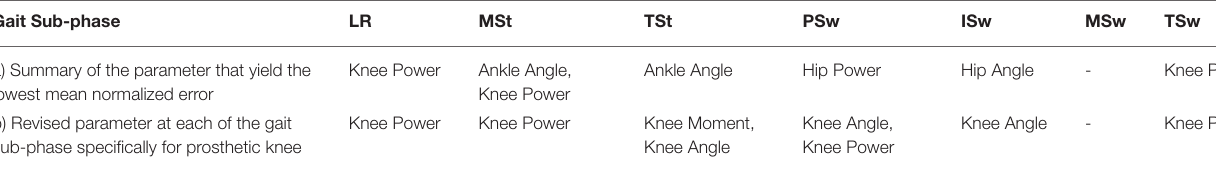
TABLE 5 | Manipulated parameter that yield the lowest mean normalized error, ¯E. Gait Sub-phase